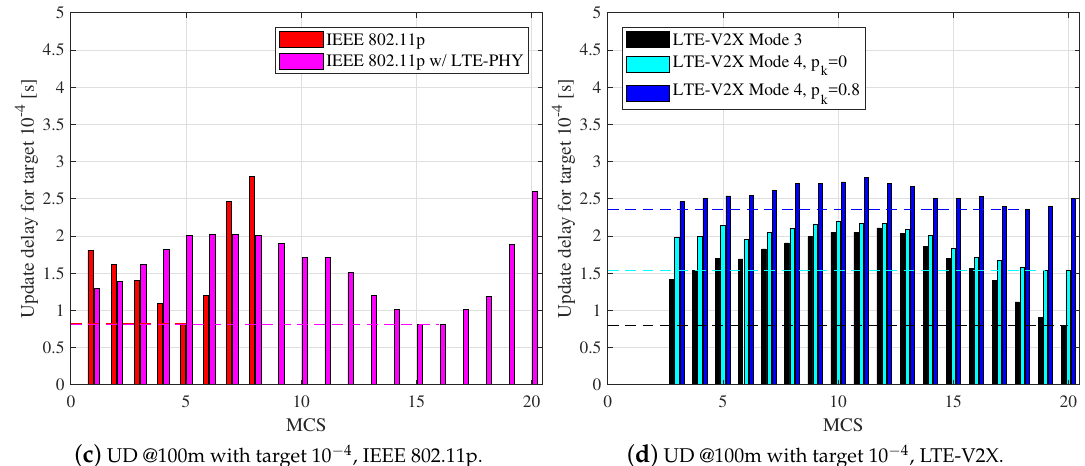
Figure 5. Packet reception ratio and update delay in Cologne.